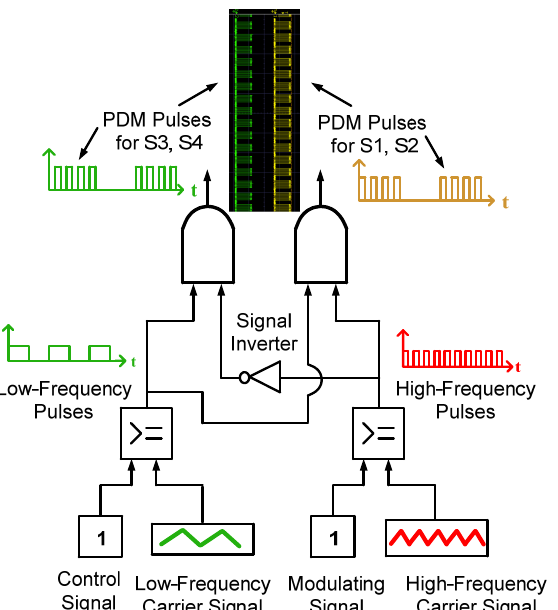
Figure 21. Experimental setup of the proposed MVR-based IH system.